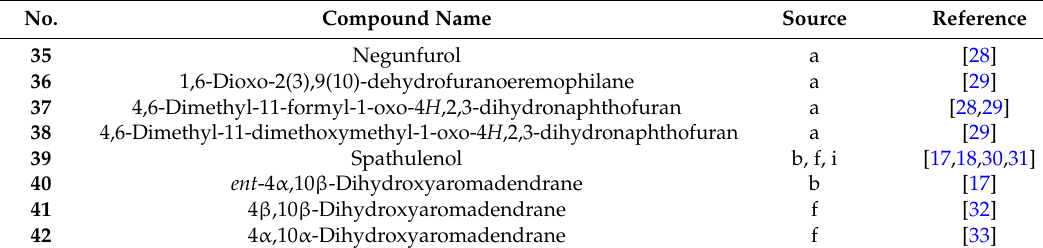
Table 2. Sesquiterpenoids 35 – 42 isolated from plants of Vitex L.